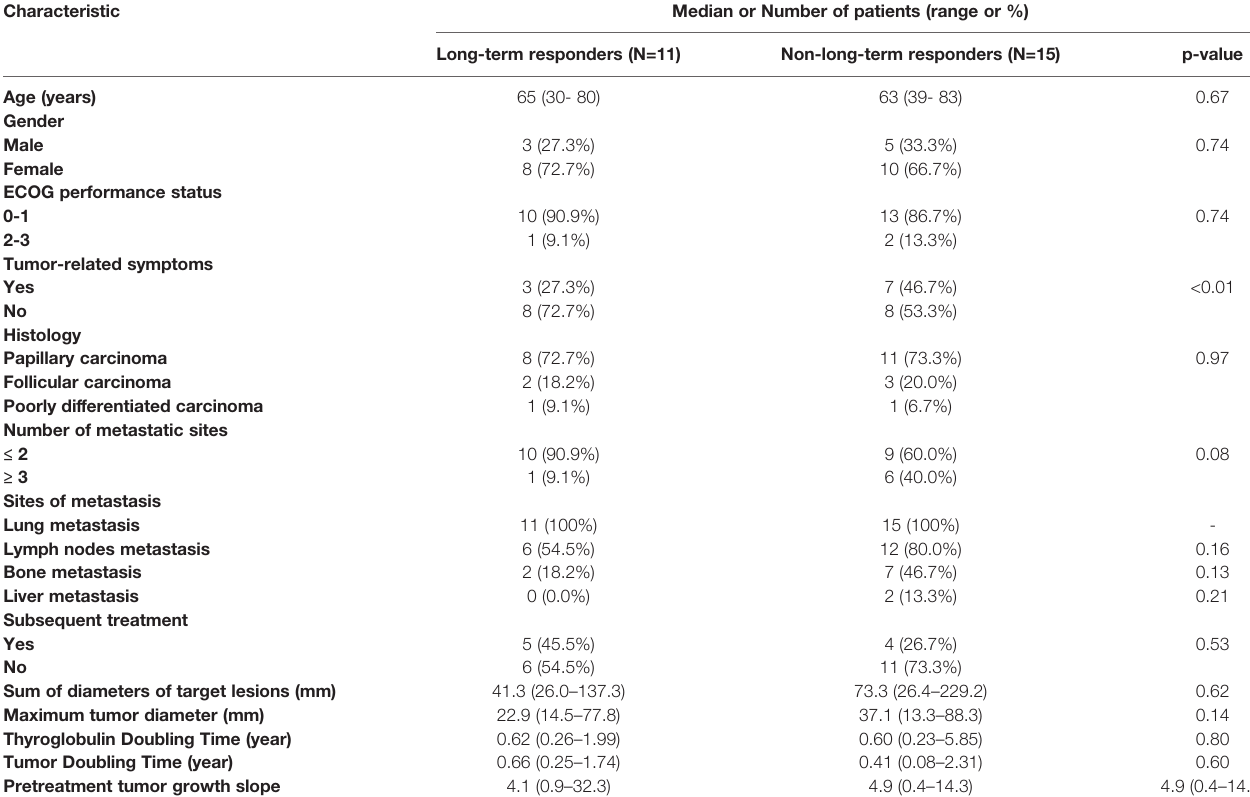
Median or Number of patients (range or